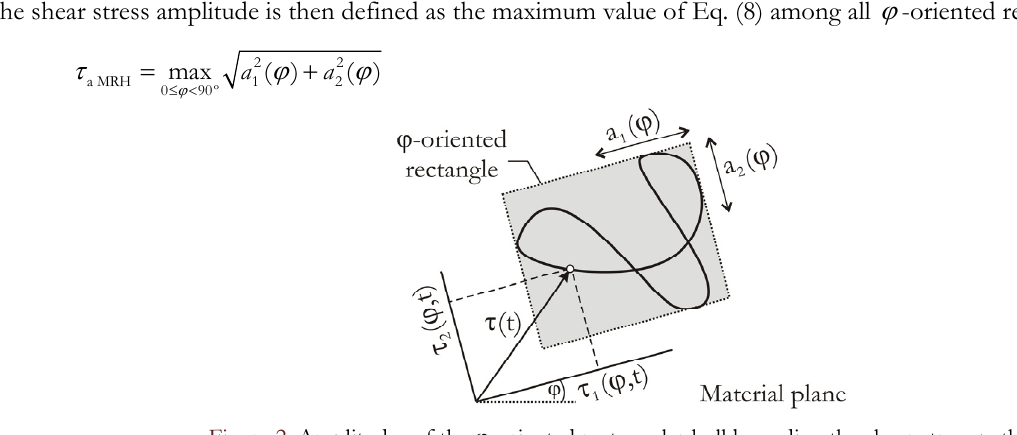
Figure 2: Amplitudes of the  -oriented rectangular hull bounding the shear stress